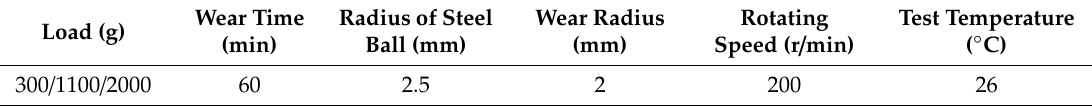
Table 5. Wear test